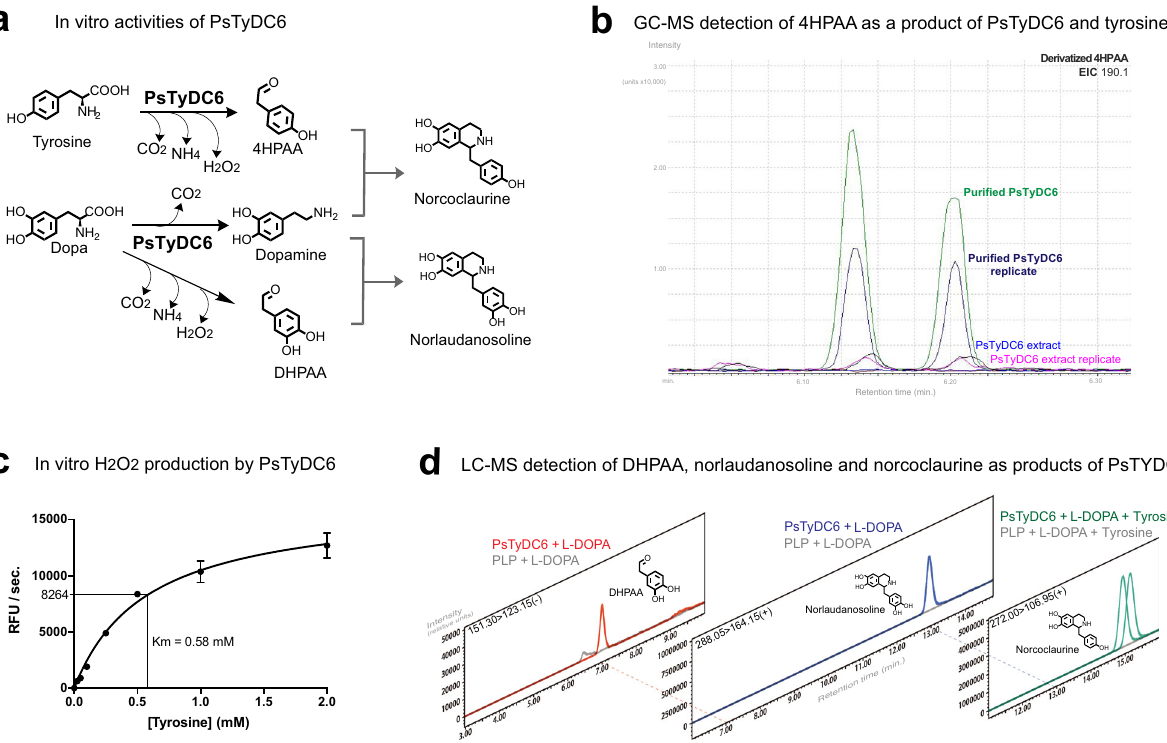
Fig. 3 PsTyDC6 exhibits in vitro AAS activity. a PsTyDC6 produces 4HPAA and tyramine from tyrosine, and DHPAA and dopamine from L-DOPA. b Derivatized 4HPAA, from reactions with puri fi ed PsTyDC6 (green and dark blue) and PsTyDC6 extracts (blue and magenta), is detected with GC-MS, as shown in the extracted ion chromatogram (EIC). Lyophilized enzyme reactions were derivatized with methoxyamine in pyridine and MSTFA before analysis with GC-MS. c H 2 O 2 production accompanies AAS activity. PsTyDC6 produced H 2 O 2 in the presence of tyrosine as indicated by a peroxidase-based fl uorescent assay. Error bars represent mean values + / − standard deviations, from three independent tests for each condition ( n = 3). d DHPAA (red), as well as downstream products norlaudanosoline (blue) and norcoclaurine (green), are detected with LC-MS. All three products were not detected in control samples (grey), containing PLP cofactor in place of PsTyDC6. Source data are provided as a Source Data fi